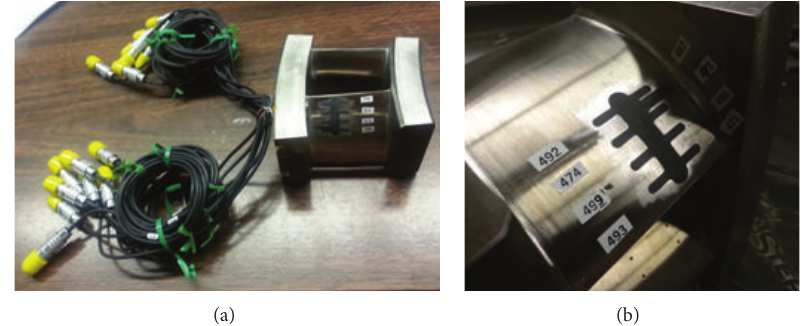
Figure 7: Photographs of the removable Stator 2 insert with pressure transducers installed.